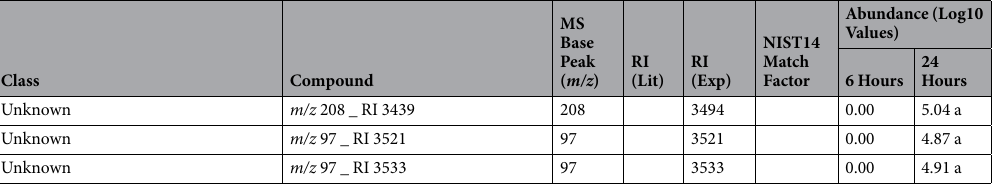
Table 7. Annotations of B. anthracis Ames-specific VOC markers and average relative abundances (n = 3) at 6 and 24 hours post inoculation. Notes: a VOC detected in 2/3 of triplicate measurements b VOC detected in 1/3 of triplicate measurements RI (Lit): Retention Index reported from NIST14 RI (Exp): Retention Index calculated from